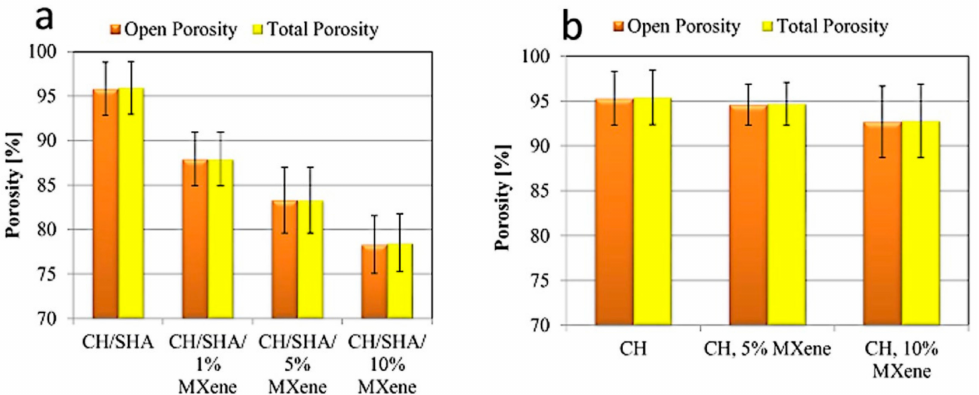
Figure 4. Results of total and open porosity calculations based on micro-CT data for the CH / SHA matrix nanocomposites modified with 1, 5, and 10 wt.% of 2D Ti 3 C 2 T x MXene flakes ( a ). For comparison, results for CH composites (with no sodium hyaluronate) are shown in ( b